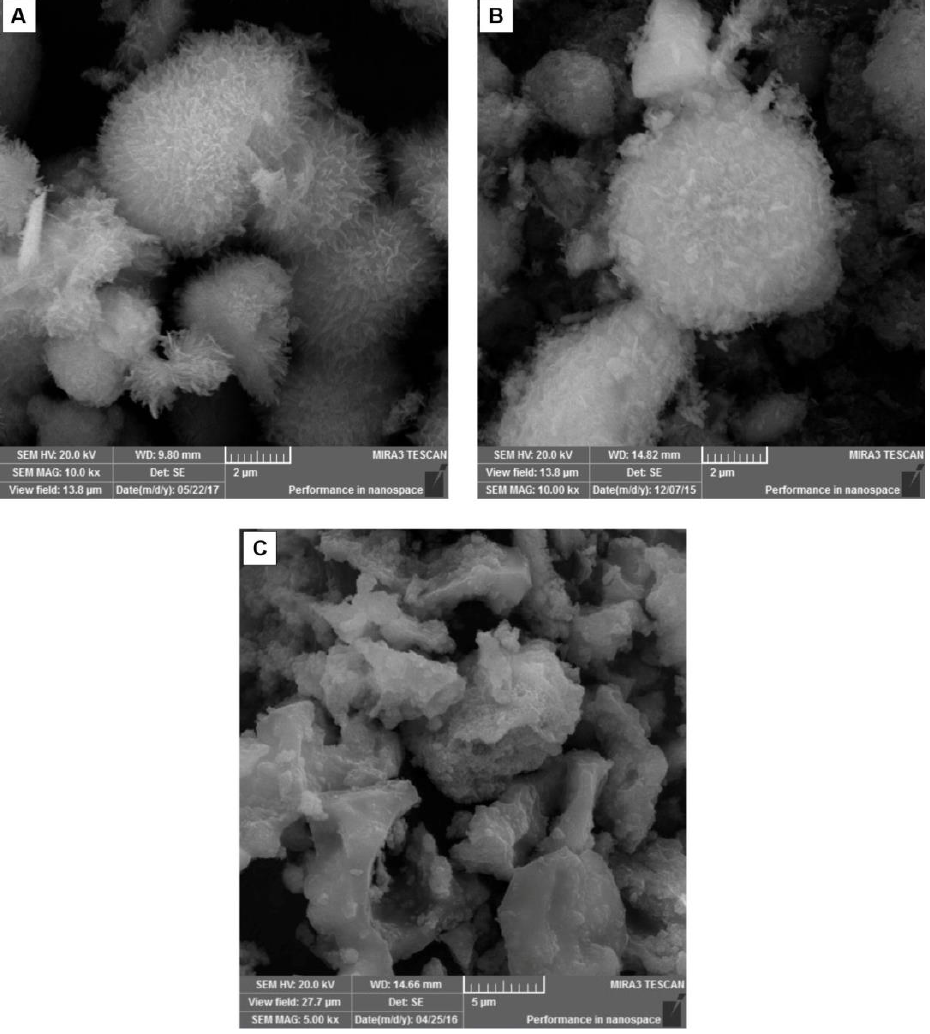
Figure 2. Characterization of HAp-based materials by FESEM photomicrographs: ( A ) HAps, hy- droxyapatite nanosheet-assembled microspheres, 10 kx magnification; ( B ) Amx–HAp, amoxicillin– hydroxyapatite composite, 10 kx magnification; ( C ) Col–HAp, collagen–hydroxyapatite composite, 500× magnification.